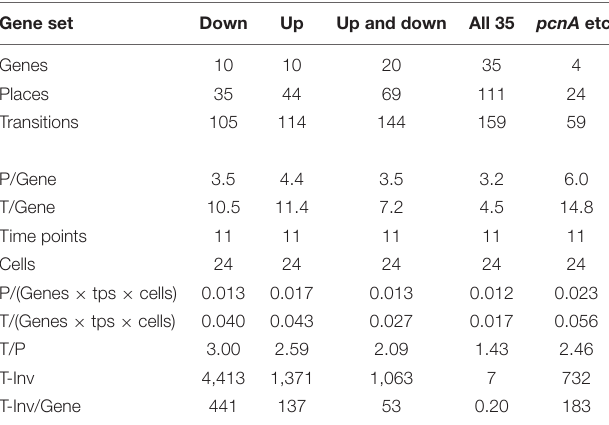
TABLE 4 | Number and relative frequency of places, transitions, and T-invariants of Petri nets constructed for different subsets of genes (see legend to Supplementary Figure 4 ) from the data of cells listed in Table 2